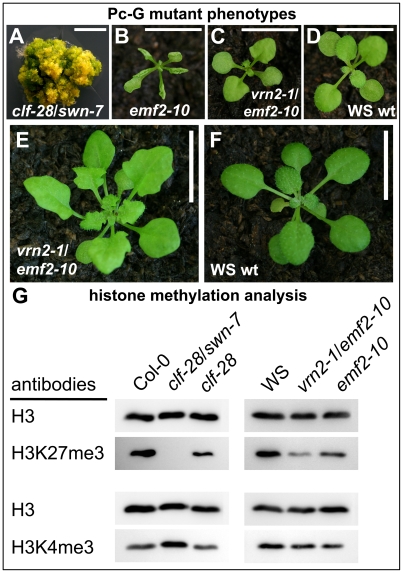
Immunoblot analyses of histone modifications in Pc-G mutants.(A) clf-28/swn-7 double mutants, 60 d old and grown in axenic conditions in long days, (B) emf2–10, (C) vrn2–1/emf2–10 double mutants, (D) Wassilewskija (WS) wildtype. Plants in (B)–(D) are 17 old and grown in short day conditions. (E), (F) 45 d old plants grown under short day conditions, (E) vrn2-1/emf2-10 double mutant, (F) wildtype. Scale bars in pictures (A) to (D) indicate 0.5 cm and in (E) and (F) 1 cm. (G) Immunoblot analyses of H3K4me3 and H3K27me3 levels in Pc-G mutants. Similar amounts of histone H3 were loaded as confirmed with a H3 specific antibody detecting the unmodified C-terminal part of H3. Immunoblot analyses of additional histone modifications are shown in Figure S5.